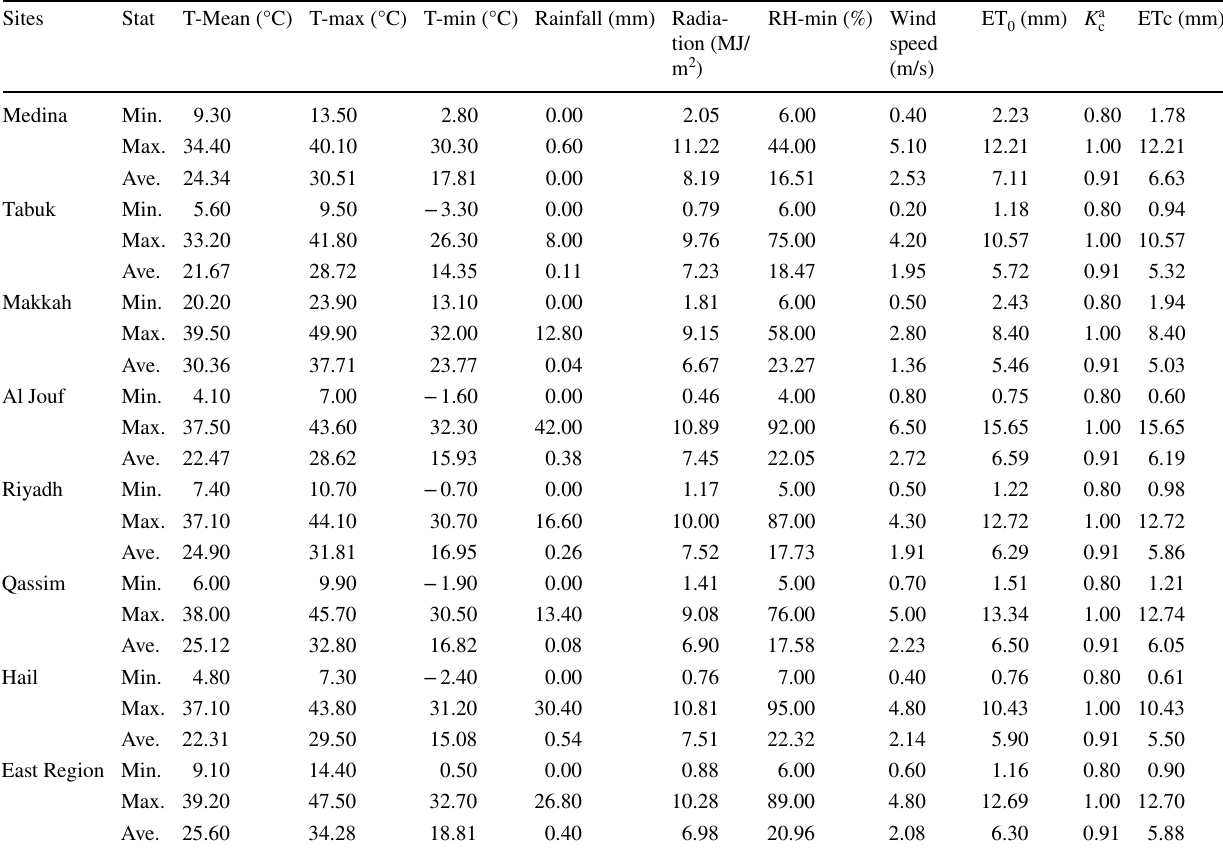
Table 3 The observed average values of the climatic variables in eight sites